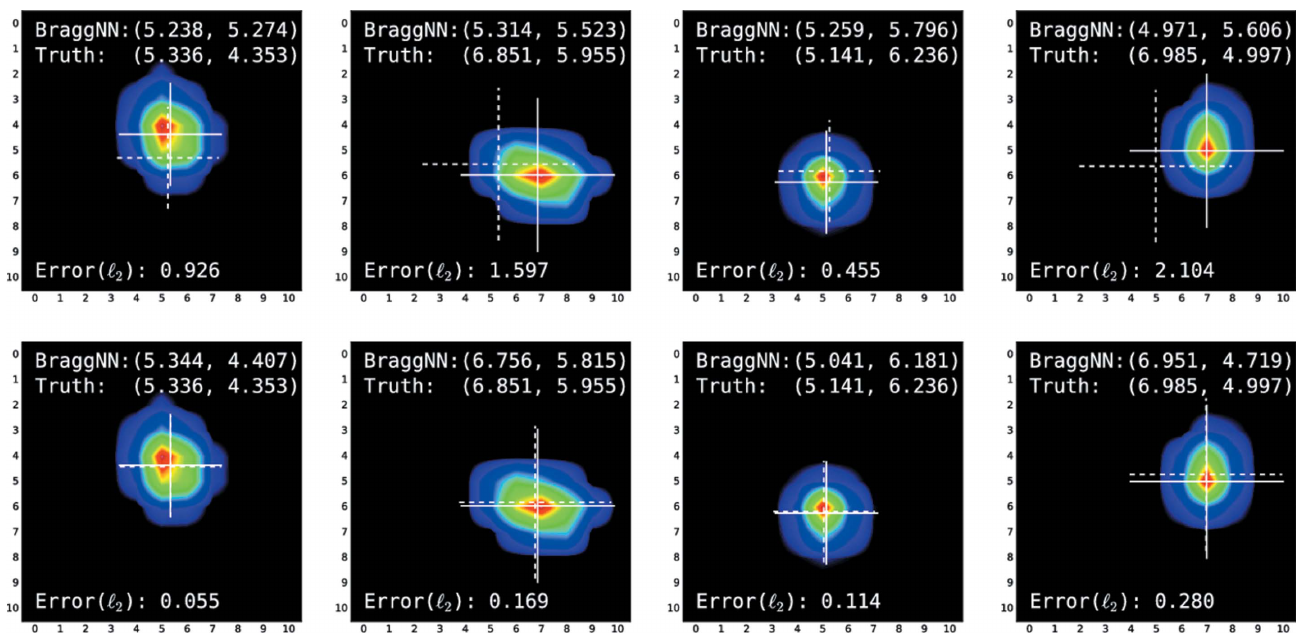
) between truth (solid-line cross) and 2